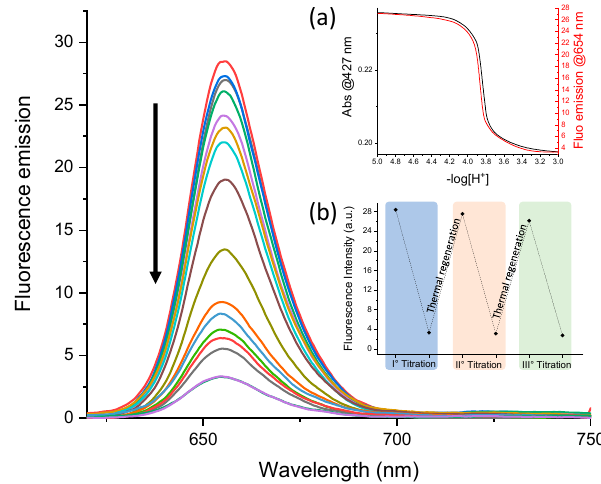
Figure 10. Spectrofluorimetric HCl titration of AgNP@P(PEG350) 3 . Inset: ( a ) titration curves obtained monitoring the fluorescence emission intensity at 654 nm (red line) and the UV-Vis absorbance at 427 nm (black line); ( b ) fluorescence emission intensity variations (at 654 nm) of AgNP@P(PEG350) 3 aqueous solution during HCl titrations cycles.